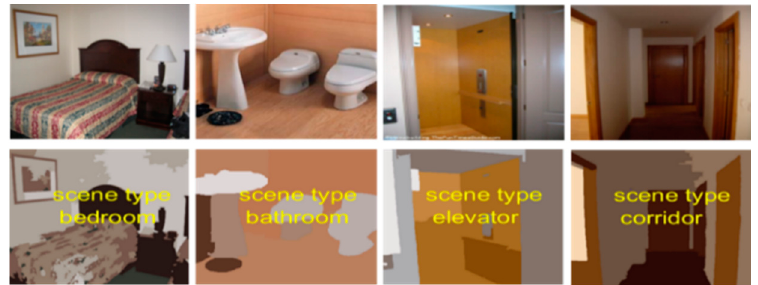
Figure 12. Some examples of indoor scene classification using the McLR algorithm over the CVPR 67 indoor scene dataset.